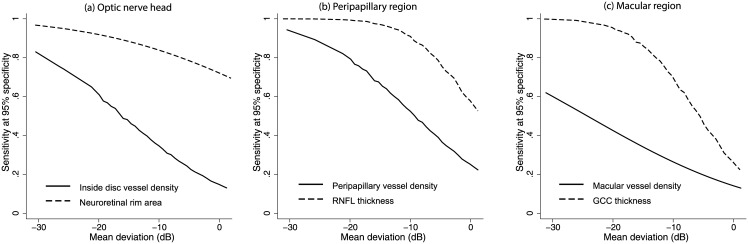
Diagnostic abilities of vessel density and structural measurements.Sensitivity at 95% specificity of (a) optic nerve head vessel density and rim area, (b) peripapillary vessel density and retinal nerve fiber layer (RNFL) thickness and (c) superficial macular vessel density and ganglion cell complex (GCC) thickness according to mean deviation on visual fields.